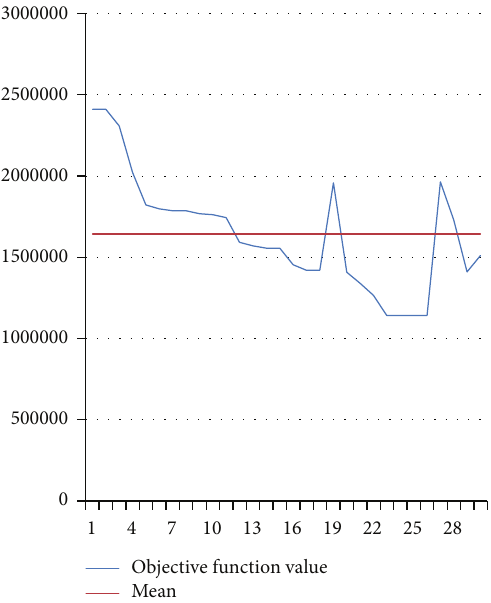
Figure 5: The fluctuation curve of optimal objective function value by